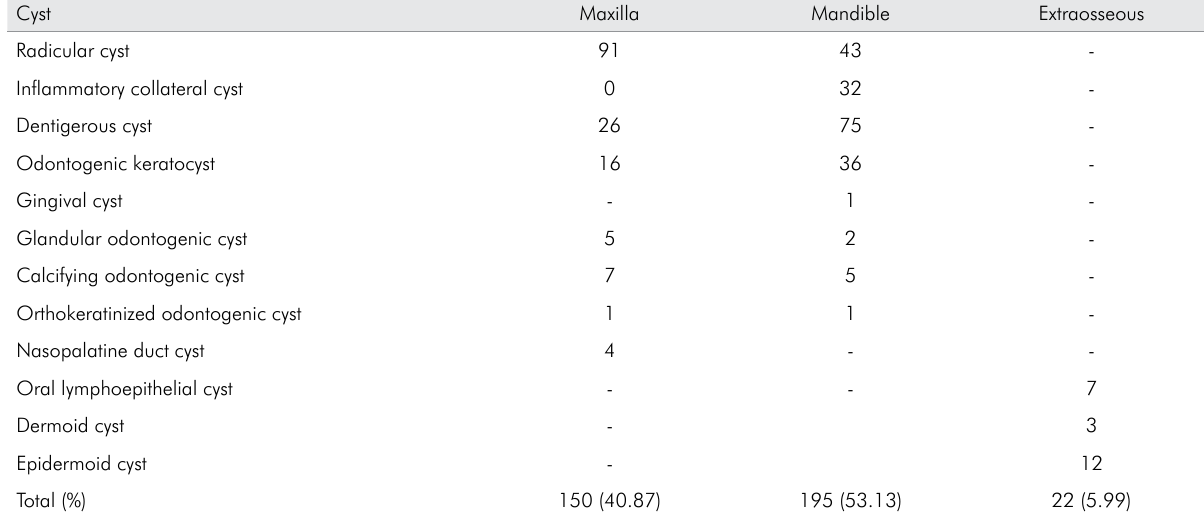
Gingival cyst Calcifying odontogenic cyst Developmental non-odontogenic cysts Nasopalatine duct cyst Dermoid cyst Epidermoid cyst Total (%)